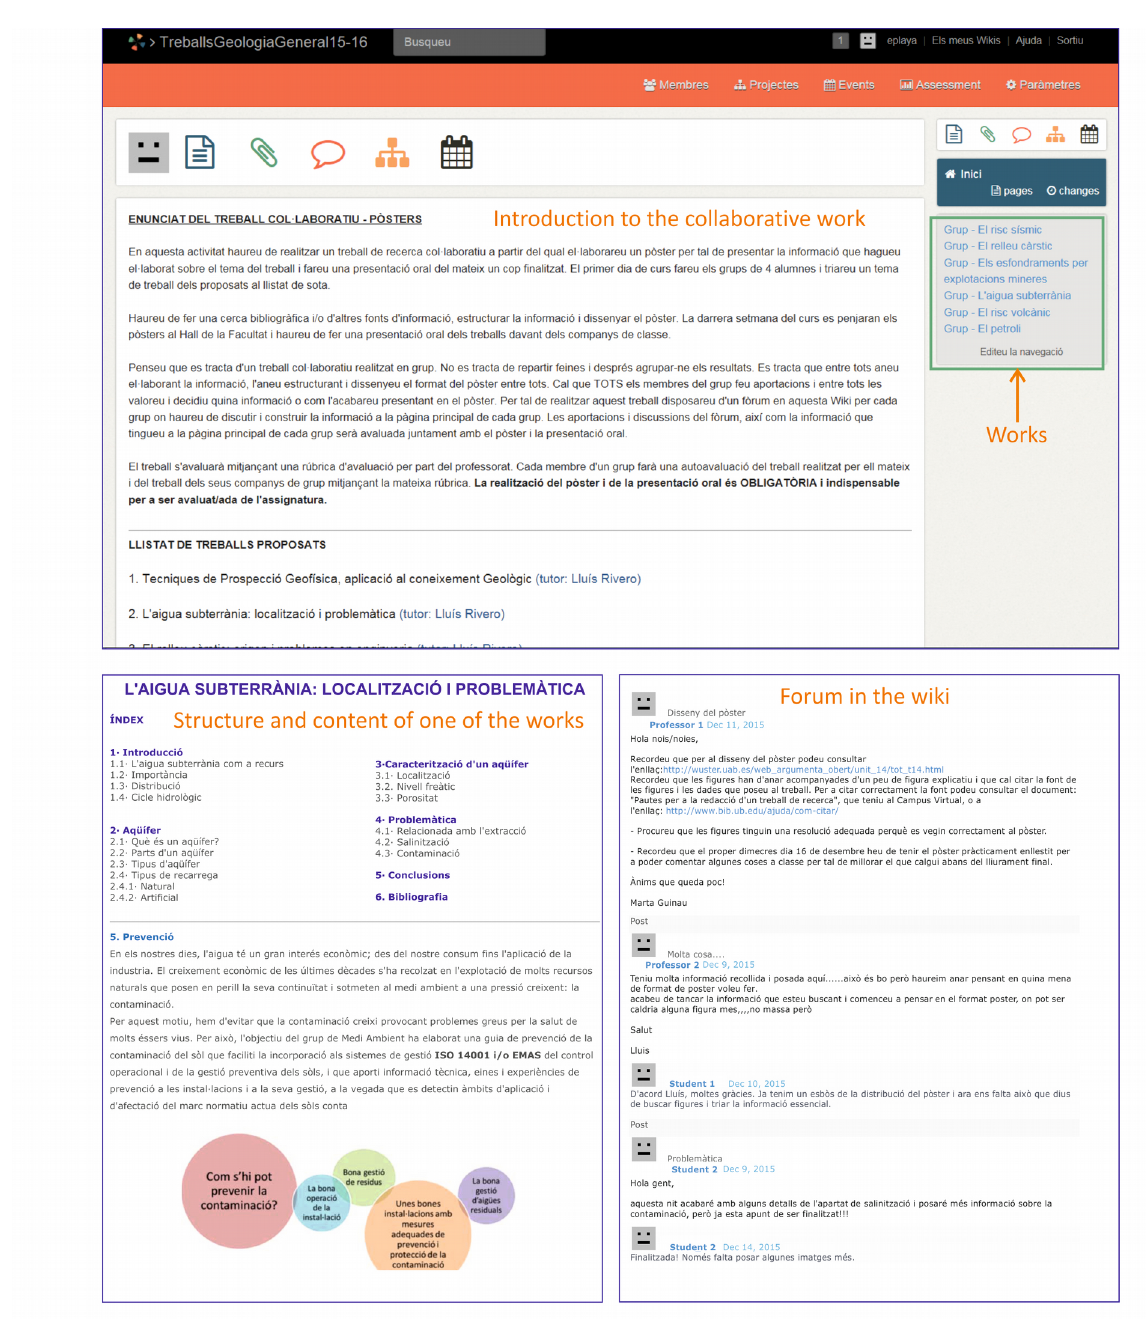
Figure 1. Example of the wiki created in www.wikispaces.com, with a main page (image above) where the collaborative work is introduced. The menu on the right bank contains the links to access to the pages of each work. The bottom left image presents an example of the structure and content of one of the works. The bottom right image shows the forum of the wiki with some messages of the students and the lecturer.